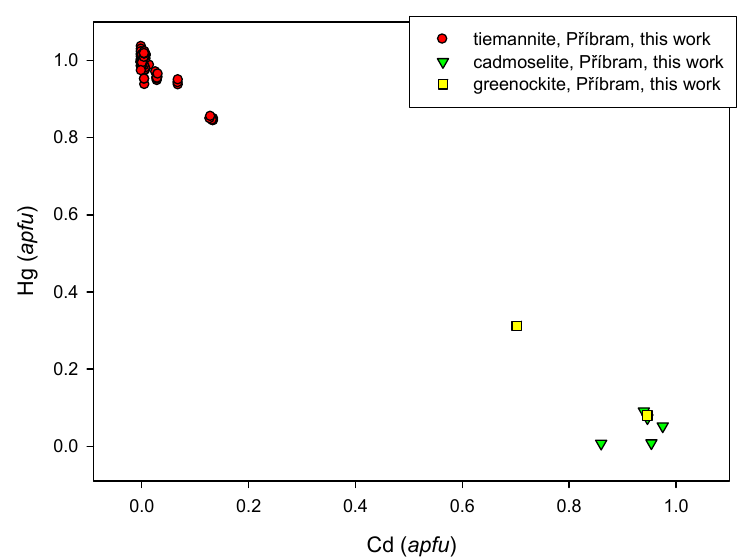
Figure 22. Cd vs. Hg ( apfu ) graph for tiemannite, cadmoselite, and greenockite from P ř íbram. Cadmoselite is a very rare mineral. In addition to the type locality—a vanadium-uranium-selenium deposit in Ust' Uyok, Siberia, Russia [84]—it is reported only from a single occurrence at the vein-type Tumiñico hydrothermal deposit by Paar et al. [79]. Greenockite occurs in the studied association as euhedral to subhedral grains up to 20 × 8 µ m with euhedral chalcopyrite grains, cadmoselite, and uraninite. In reflected light, greenockite is grey and weakly